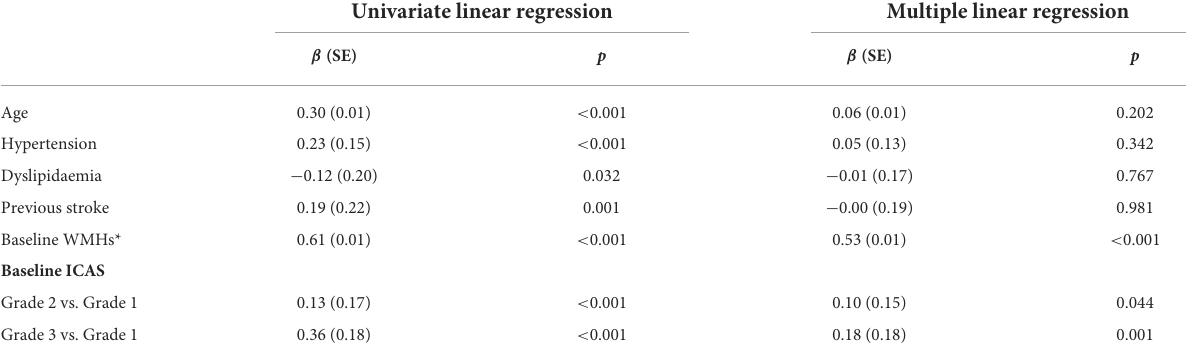
TABLE 3 Linear regression for the association between baseline ICAS severity and the WMHs progression scores. Univariate linear regression Multiple linear